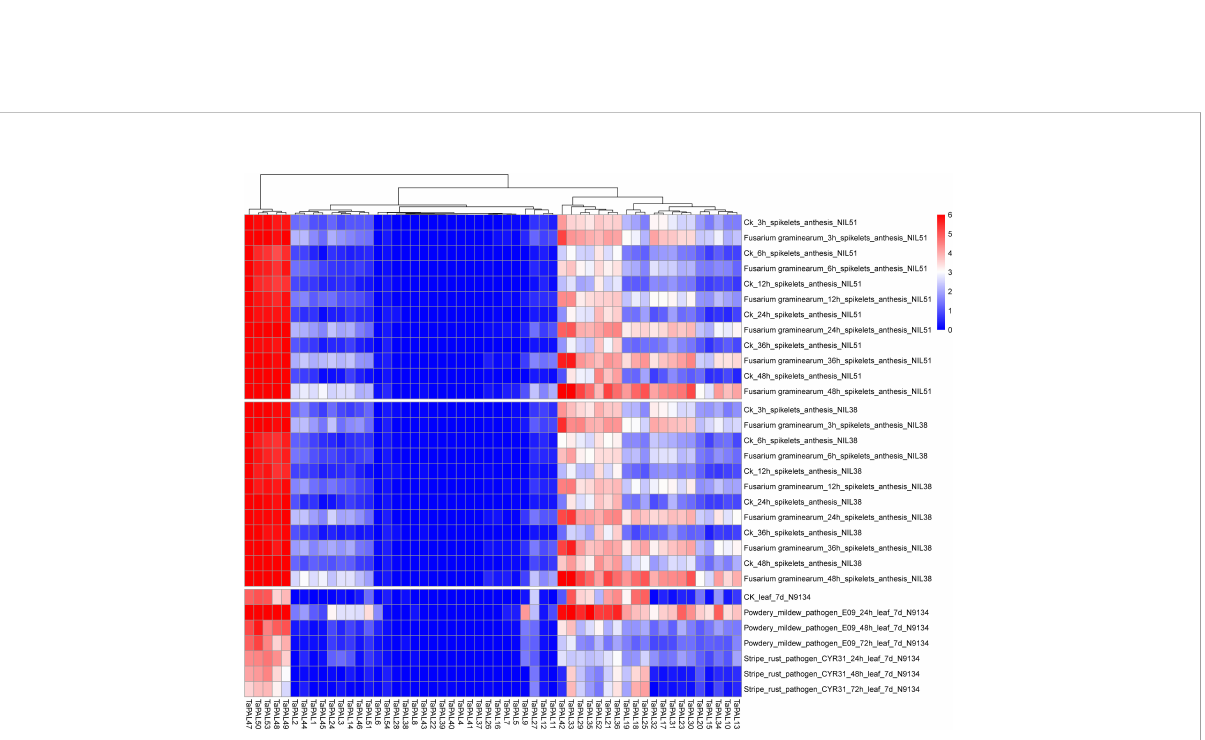
FIGURE 6 Heat map of expression pro fi les for TaPAL genes across different stresses under different biotic stress. Blocks with colors indicate decreased (blue) or increased (red) expression levels. The gradually change of the color indicates different level of gene log2-transformed expression (fold change > 3 is signi fi cantly